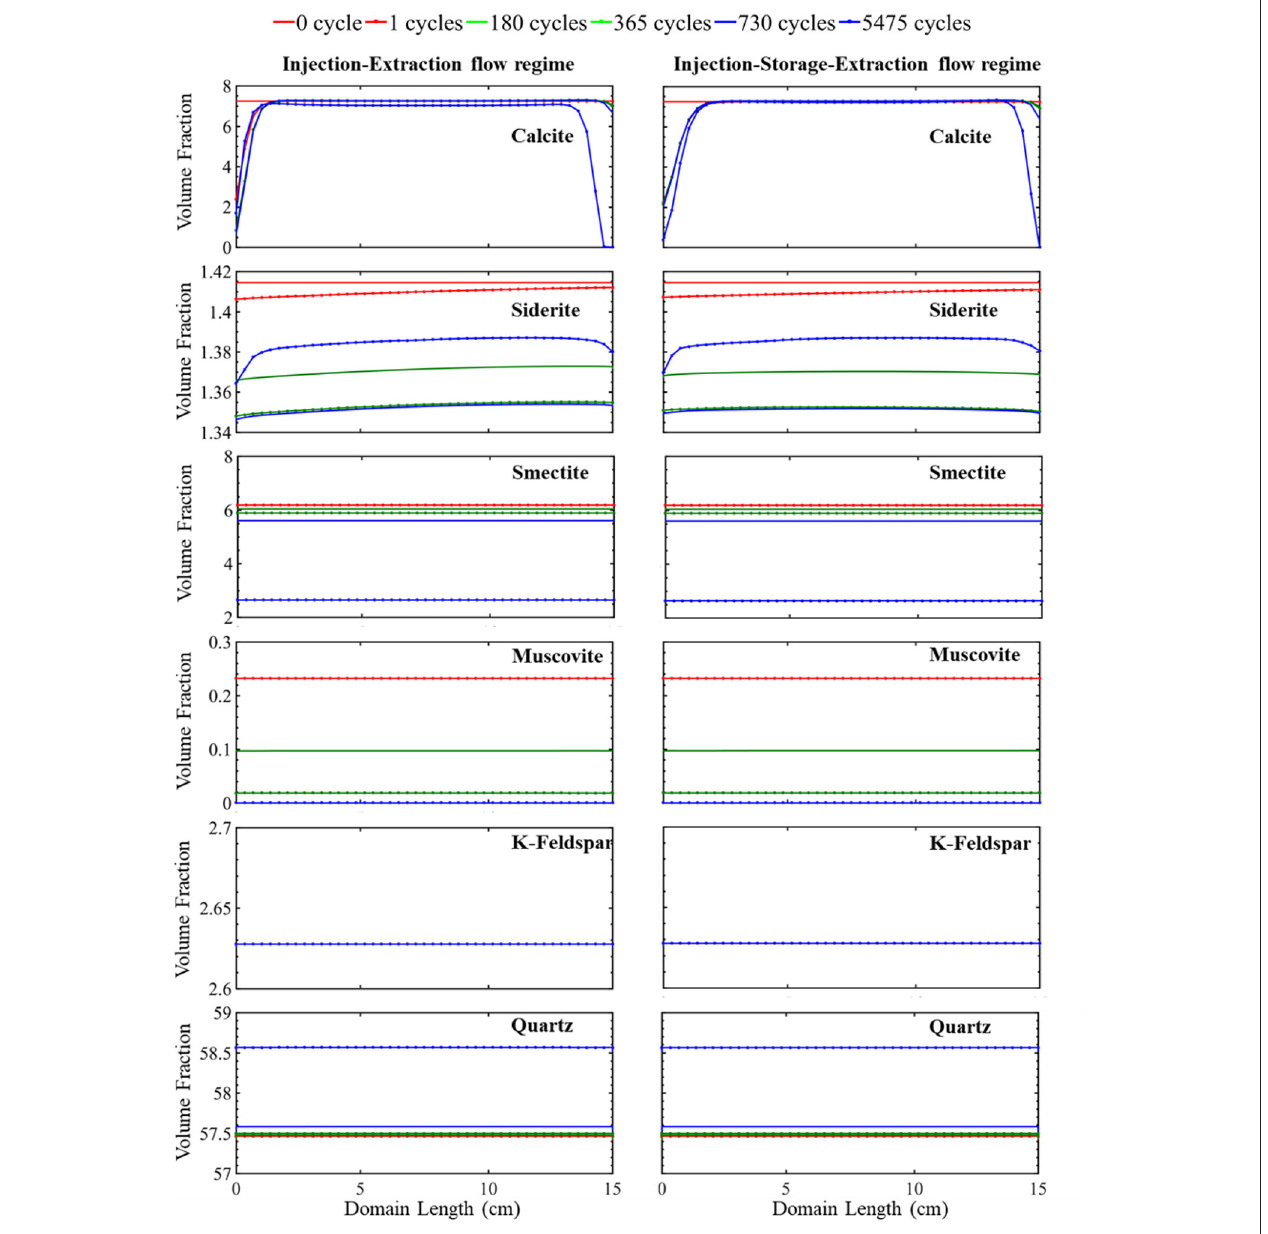
FIGURE 2 | The simulated evolution of mineral volume fractions across the simulation domain at certain times over 15 years for the injection–extraction flow regimes (left) and injection–storage–extraction flow regimes (right). 0h is the initial condition, and 15 years is the last condition of the porous media. Red reflects 0h, dotted red 1 day, green 0.5 years, dotted green 1 year, blue 2 years, and dotted blue 15